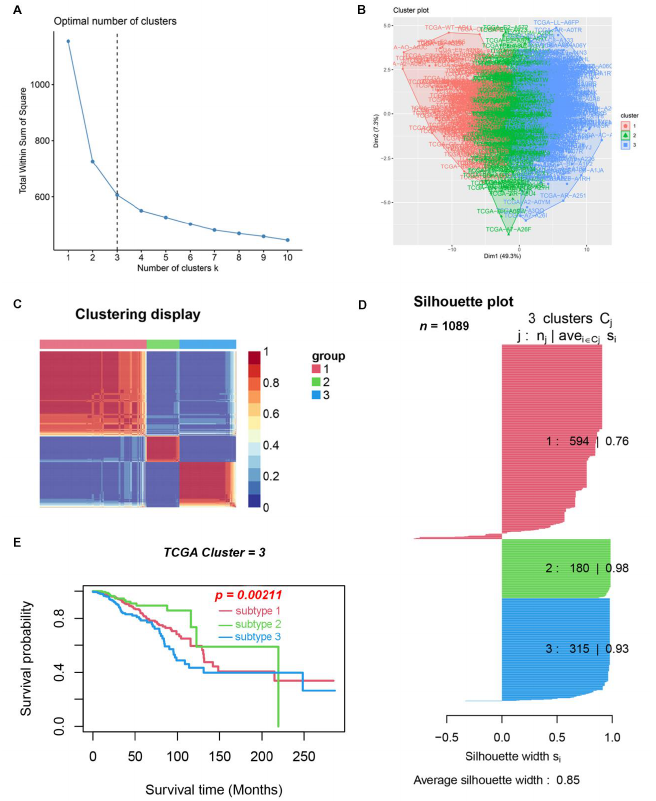
Figure 2. Identification of clinical subtypes associated with BC in TCGA. ( A ) Third, the optimal number of clusters. ( B ) Visualize the cluster results. ( C ) Nonnegative matrix decomposition (NMF) was used for cluster analysis of BC samples. ( D ) Results of the silhouette width plots. ( E ) Kaplan – Meier survival analysis of three BC subtypes.